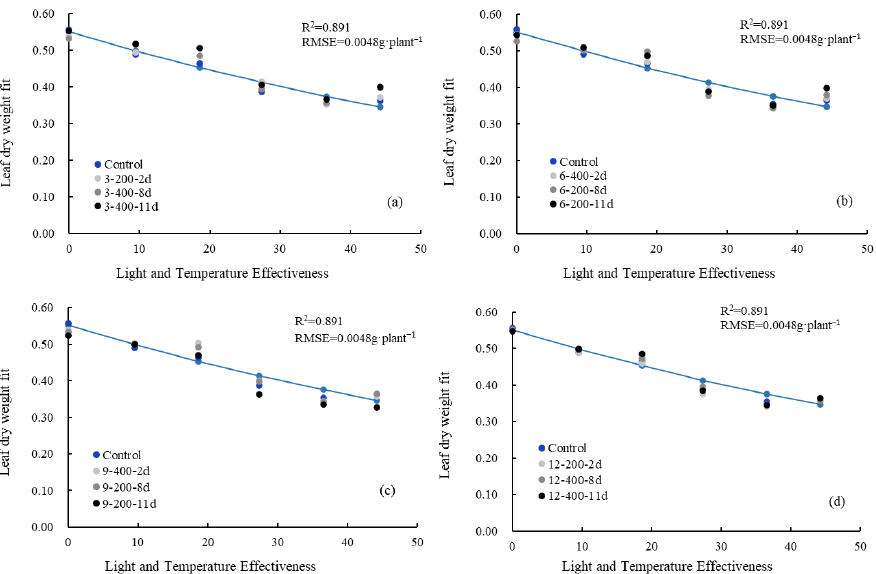
single cucumber fruits with LTE under 9 °C treatments. ( d ) Changes in dry weight of single cucumber fruits with LTE under 12 °C treatments. Note : Control represents the variation in fruit dry weight per cucumber plant with the increase in LTE under normal growth conditions.